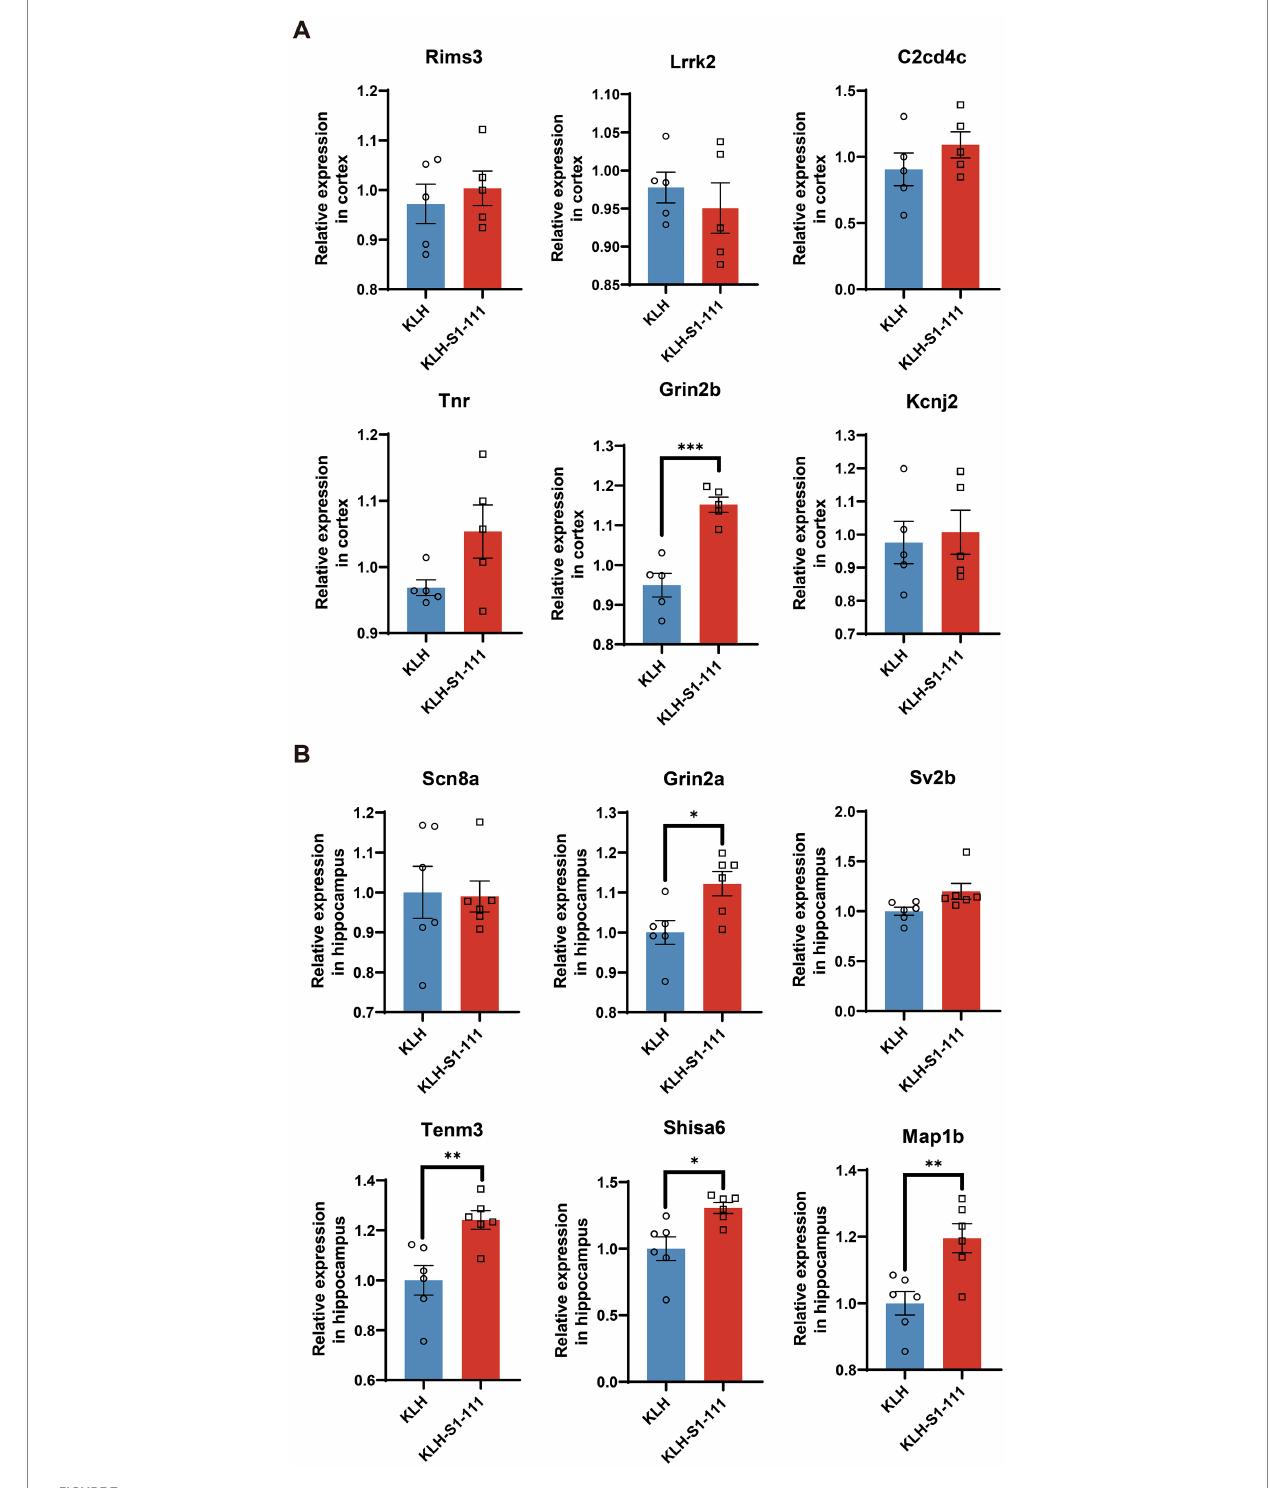
FIGURE 7 mRNA expression levels of immunized mice measured by RT–qPCR. (A) The RT–qPCR results in the cortex, N = 5/group, p = 0.0004 for Gin2b . (B) The RT–qPCR results in the hippocampus, N = 6/group, p = 0.0169 for Gin2a , p = 0.006 for Tenm3 , p = 0.0112 for Shisa6 , p = 0.0059 for Map1b . (A,B) . Unpaired Student’s t test, data are shown as teh mean ±